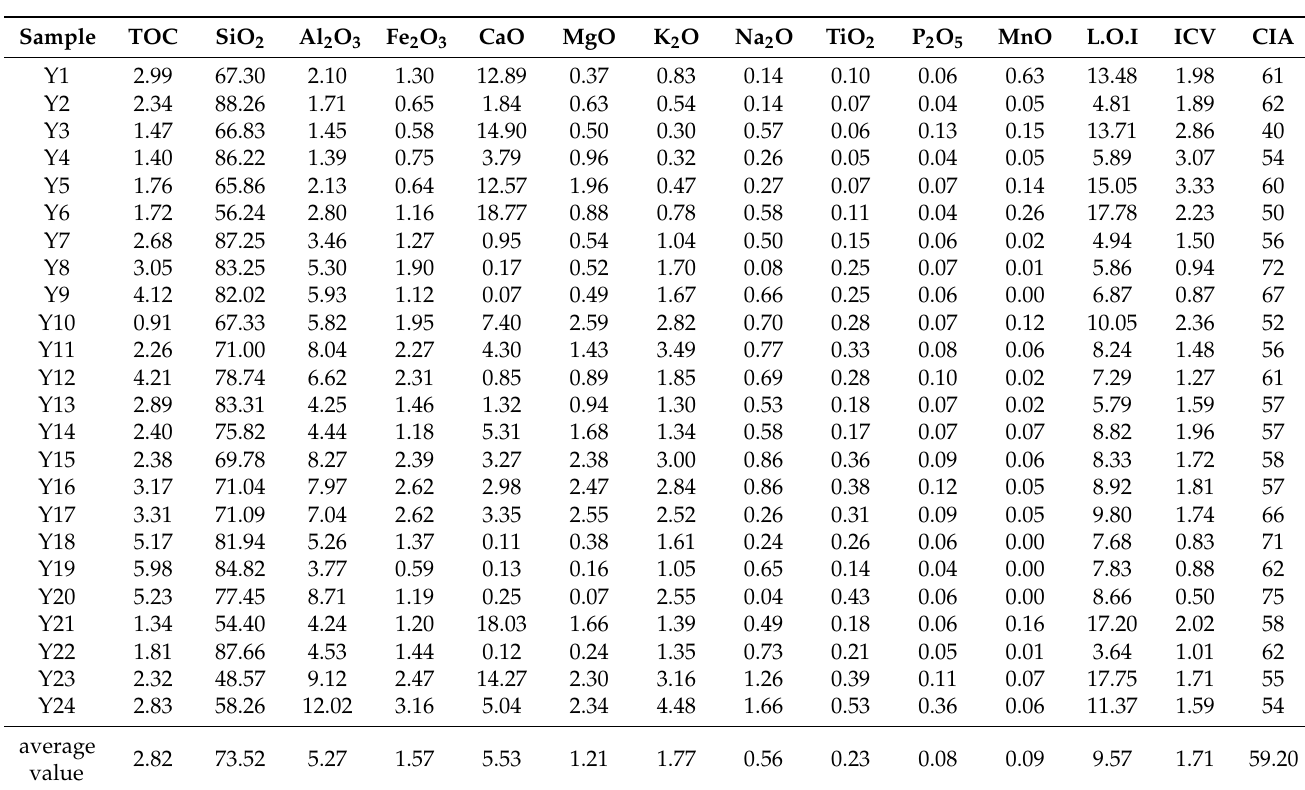
Table 2. Major element (10 − 2 ) abundances and some associated parameters of Longmaxi mudstones from the Yanyuan